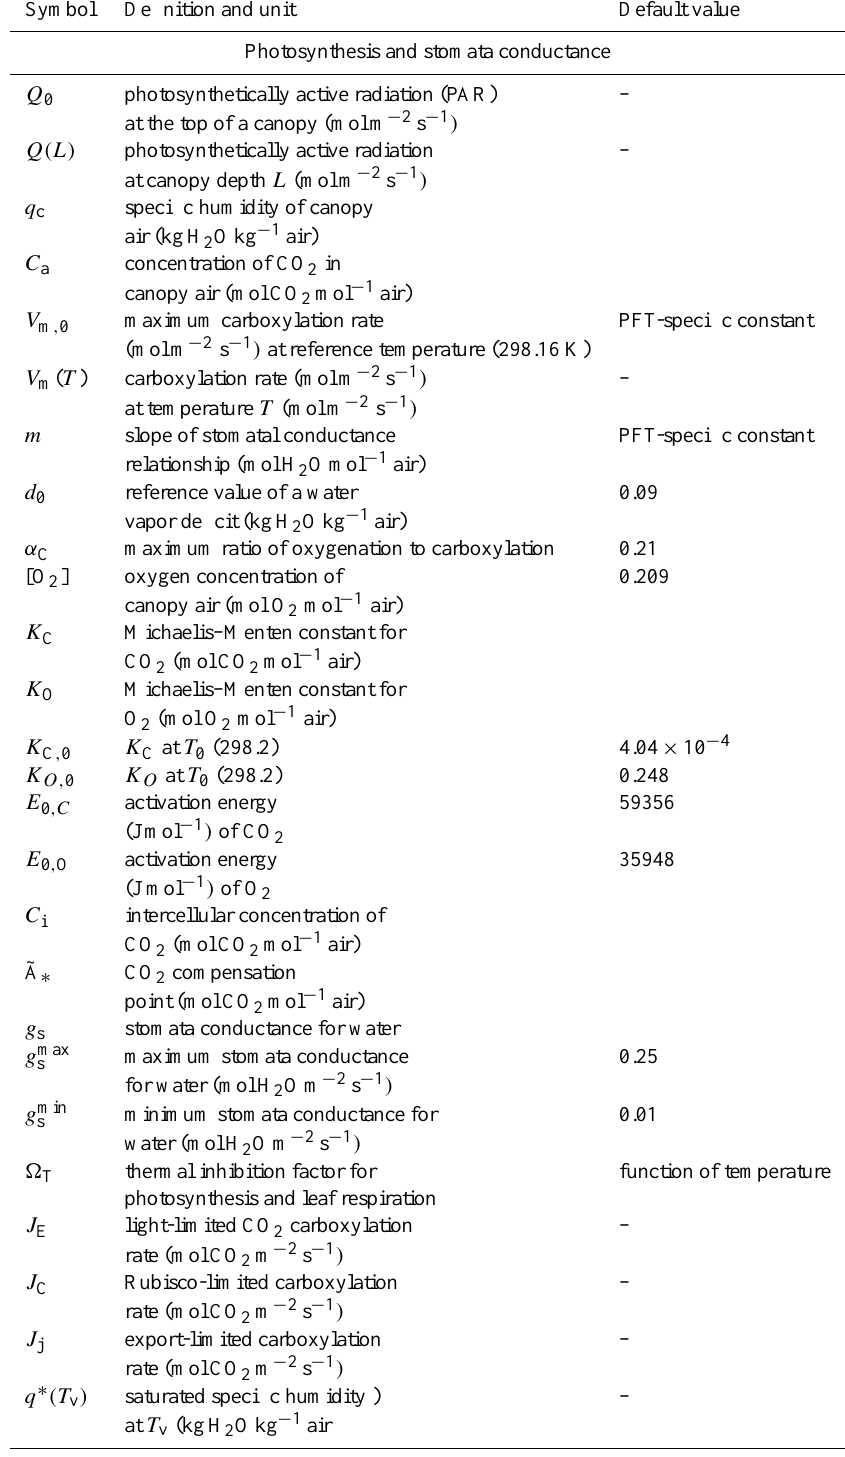
Table C2. Photosynthesis, stomata conductance, and root water